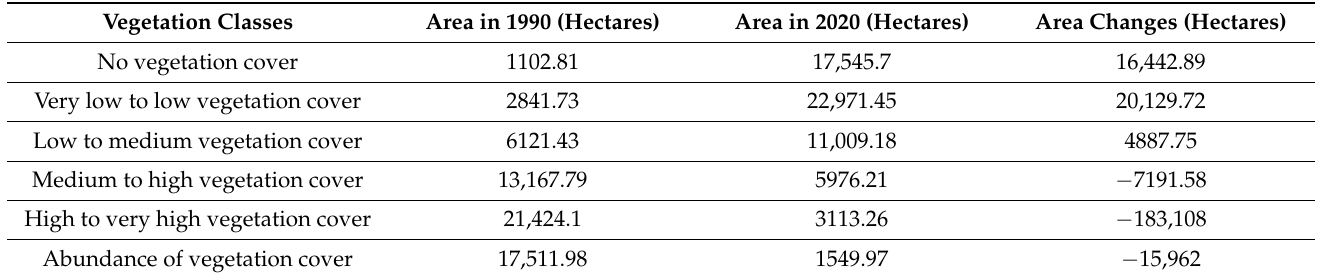
Table 3. Change of vegetation index classes in the metropolis of Tehran between 1990 and